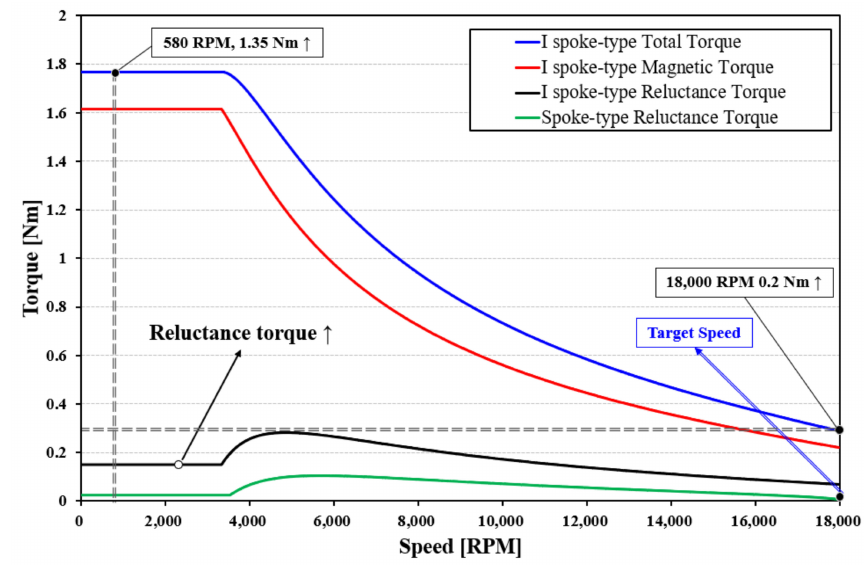
Figure 6. T-N curve of I spoke-type PMSM.